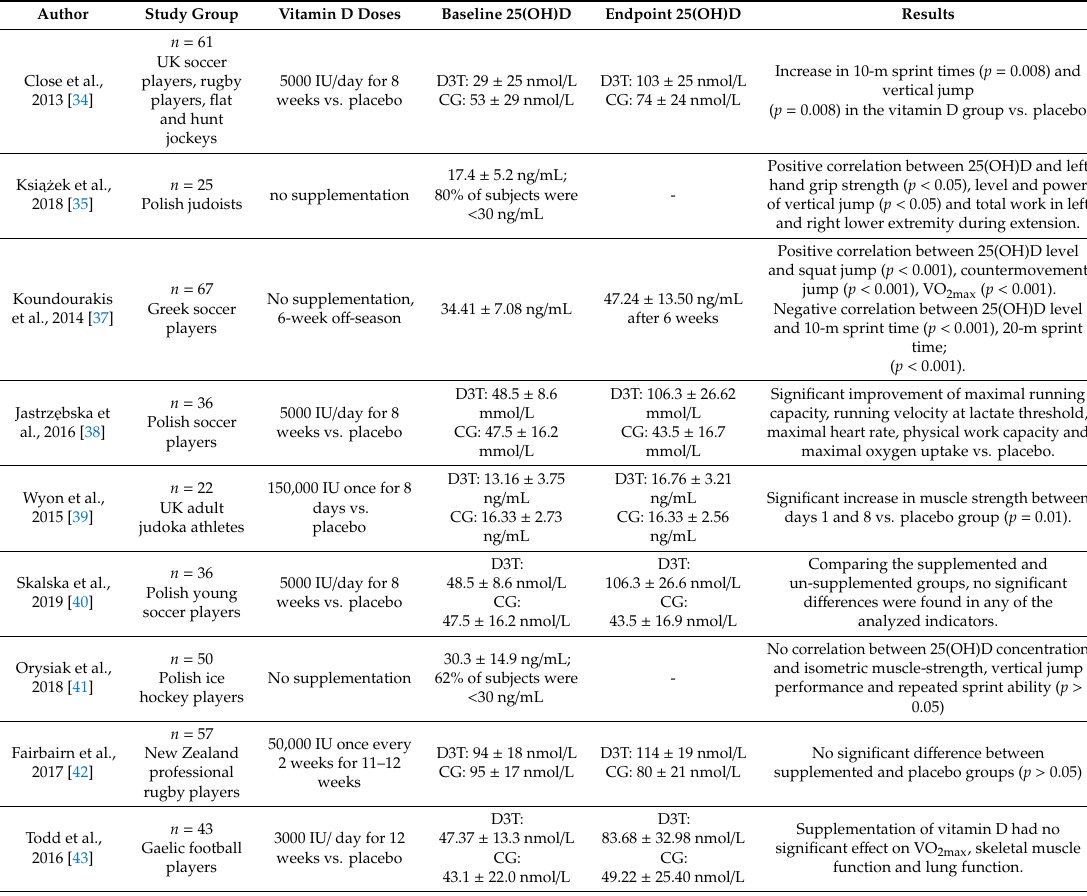
Table 1. Vitamin D and sport